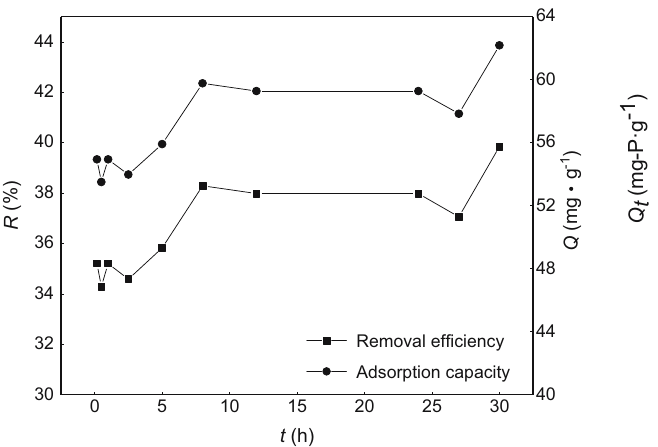
Figure 5: The pseudo - fi rst - order kinetic fi tting of phosphorus adsorption on synthetic